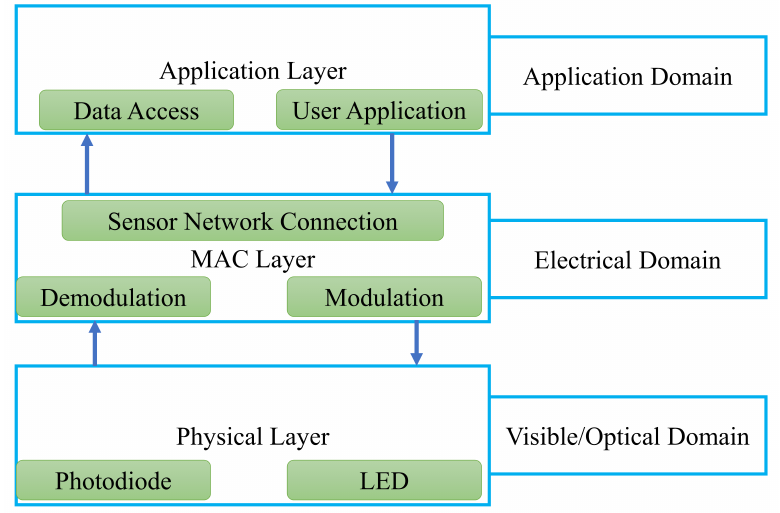
Figure 3. Visible light communication